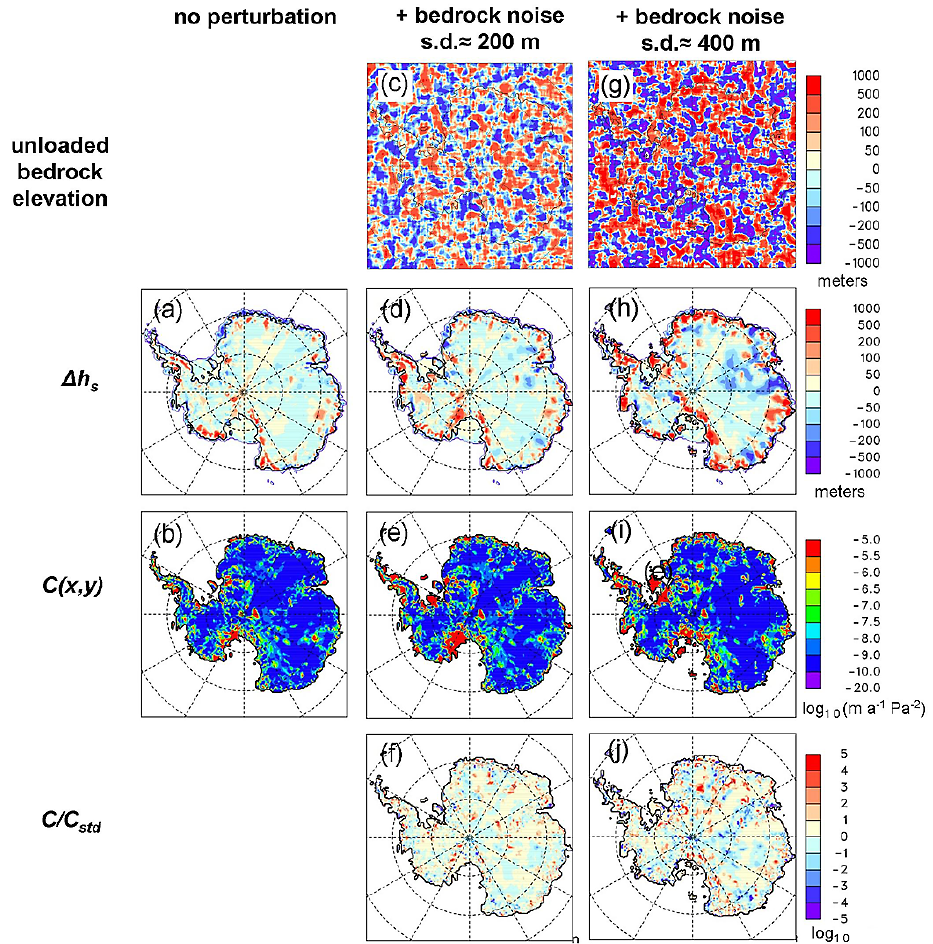
Fig. F3. Inverse runs with sub-grid topographic influence and Gaussian noise added to unloaded bedrock topography. Top row: added noise, m, smoothed to eliminate scales < 200km. Second row: model minus observed surface ice elevation, meters. Third row: basal sliding coeffi- cients C(x,y) , log 10 (ma − 1 Pa − 2 ) . Bottom row: ratio of C(x,y) to that in (b) , i.e., log 10 (C/C panel(b) ). Left column (a–b) : no noise added. Middle column (c–f) : with root-mean-square noise amplitude=199m. Right column (g–j ): with root-mean-square noise